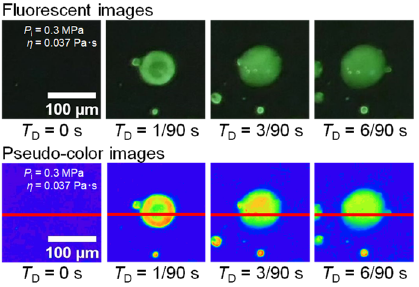
Figure 5. Fluorescent and pseudo-color images of the paint droplet.